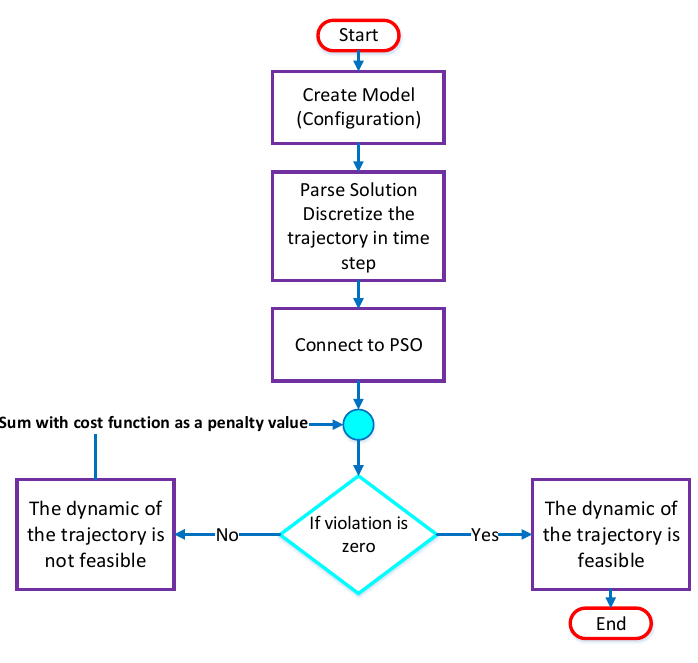
Figure 3. Flowchart of trajectory generation algorithm. PSO: particle swarm optimization.